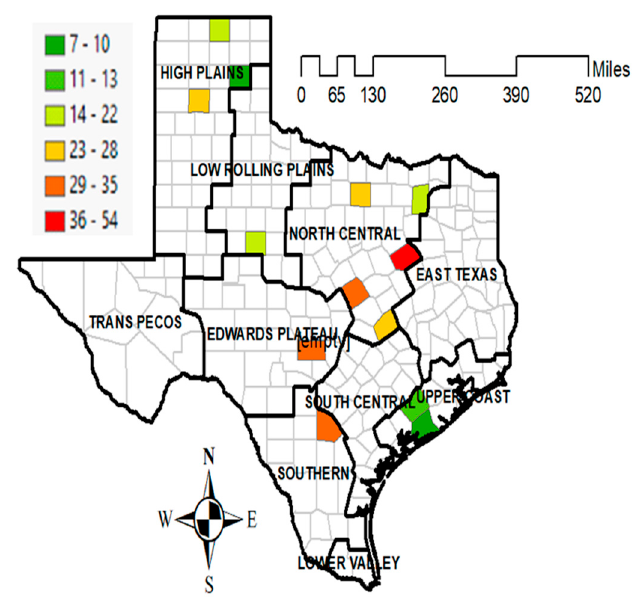
Figure 12. Percent reduction in rainfed sorghum yield between the year with excess precipitation and